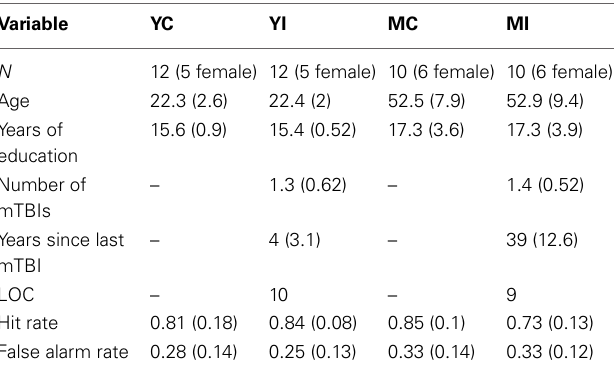
Table 1 | Participant demographics and memory performance: mean (SD).